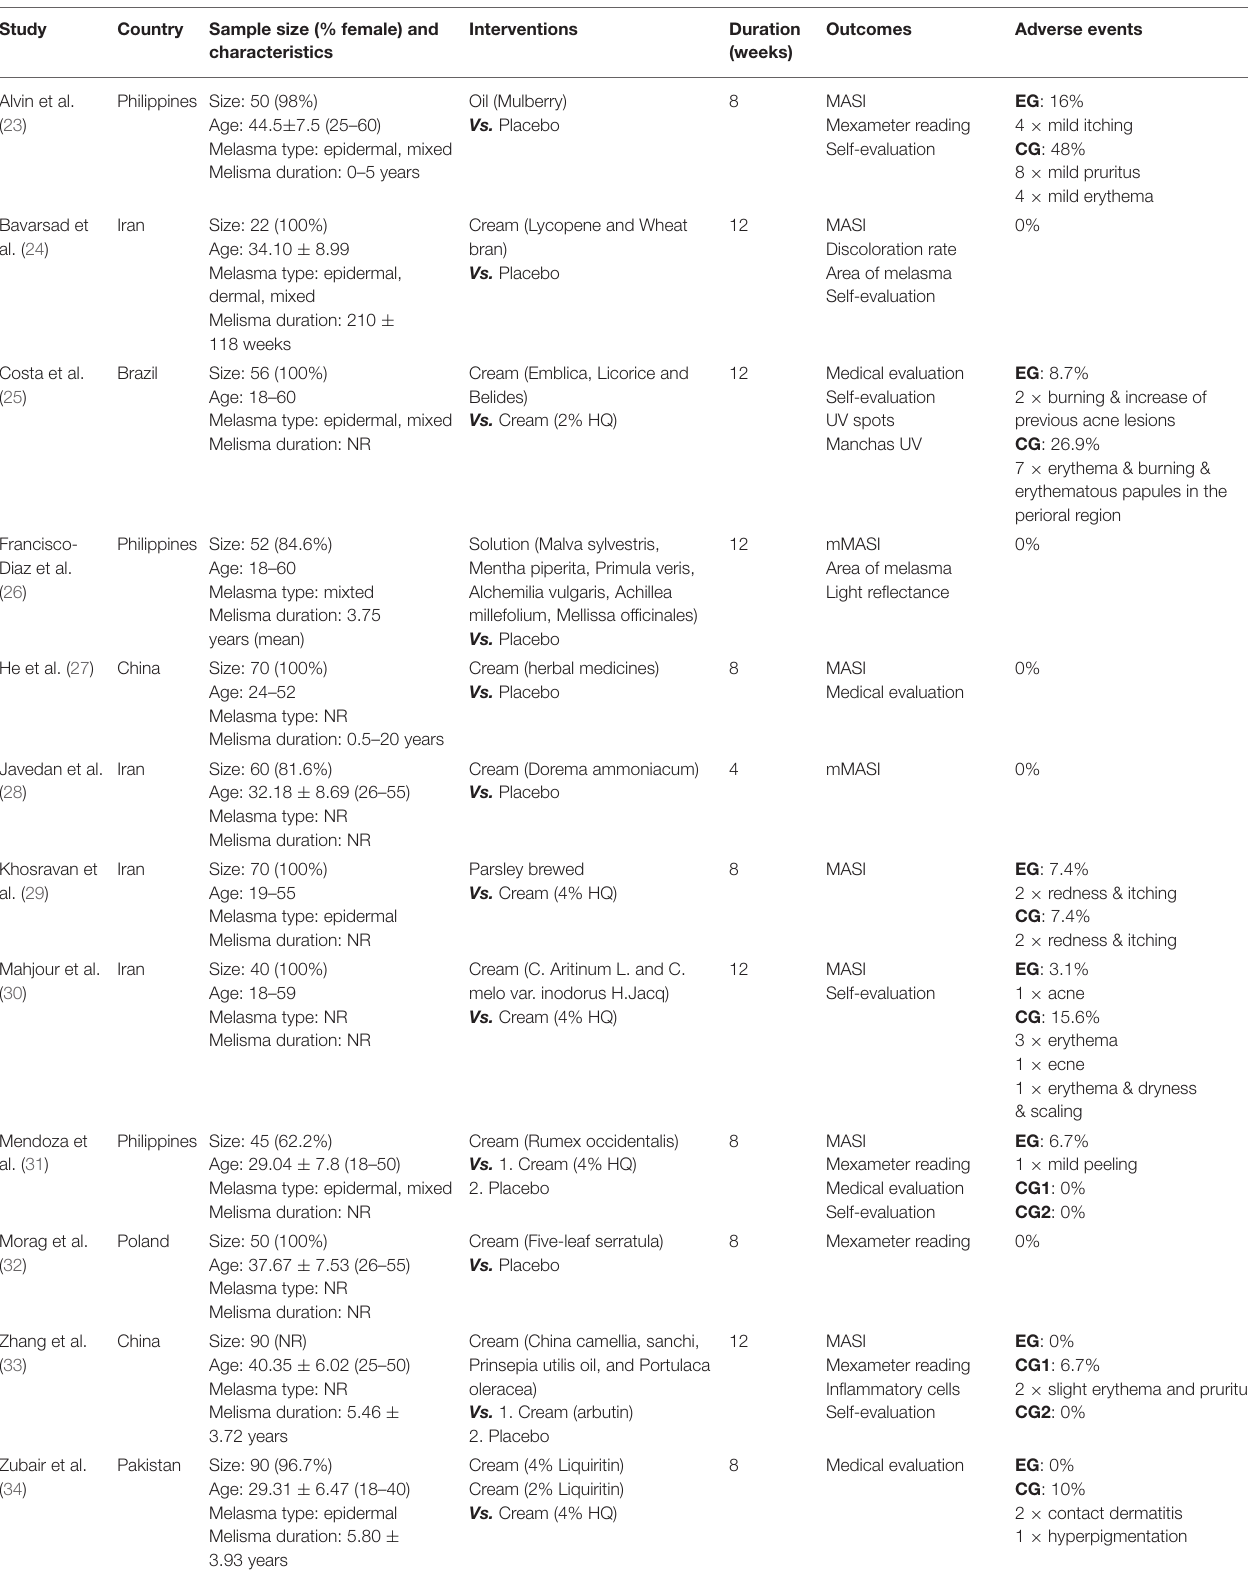
TABLE 1 | Characteristics of included